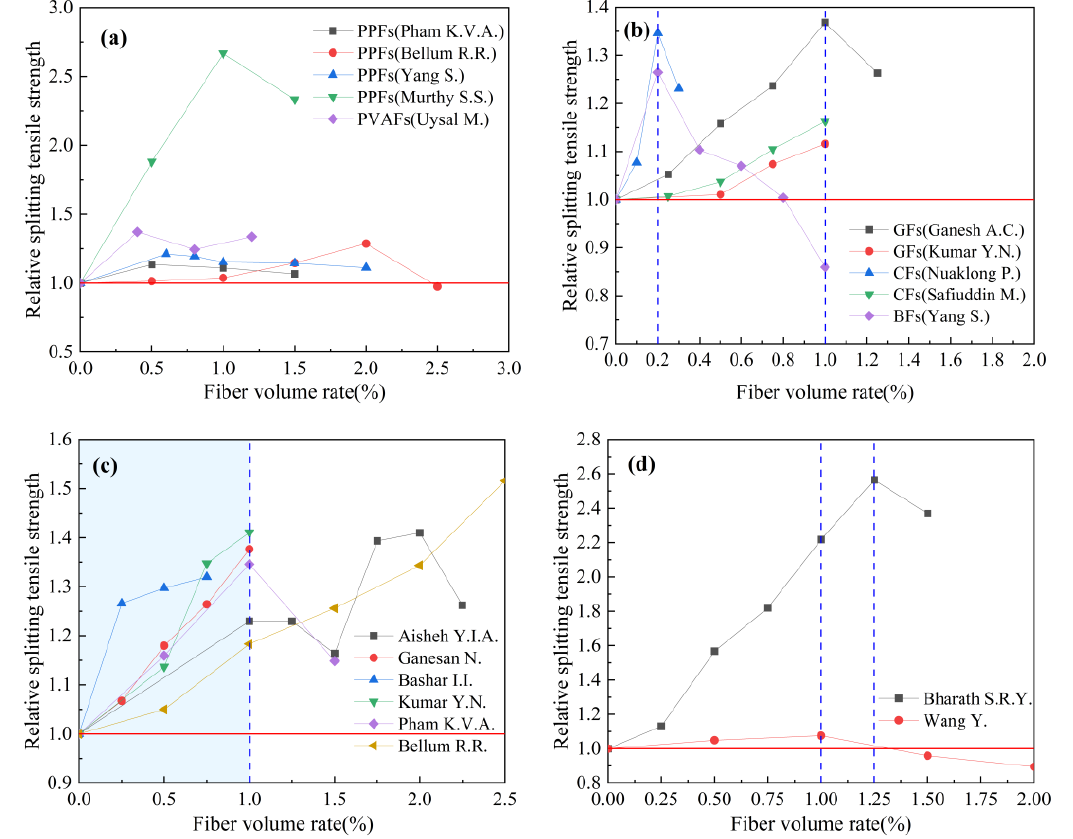
Figure 18. The effect of fiber volume rate on splitting tensile strength: ( a ) Synthetic fiber; ( b ) inorganic fiber; ( c ) steel fiber; ( d ) plant fiber.